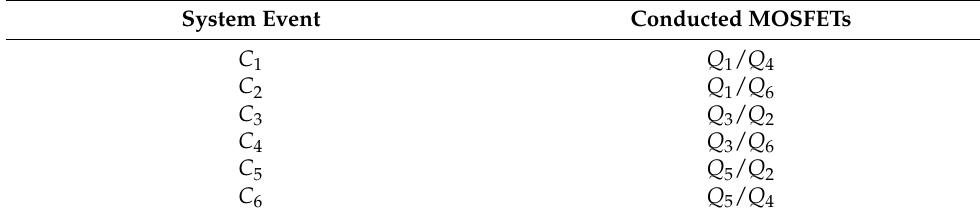
Table 3. System events of the